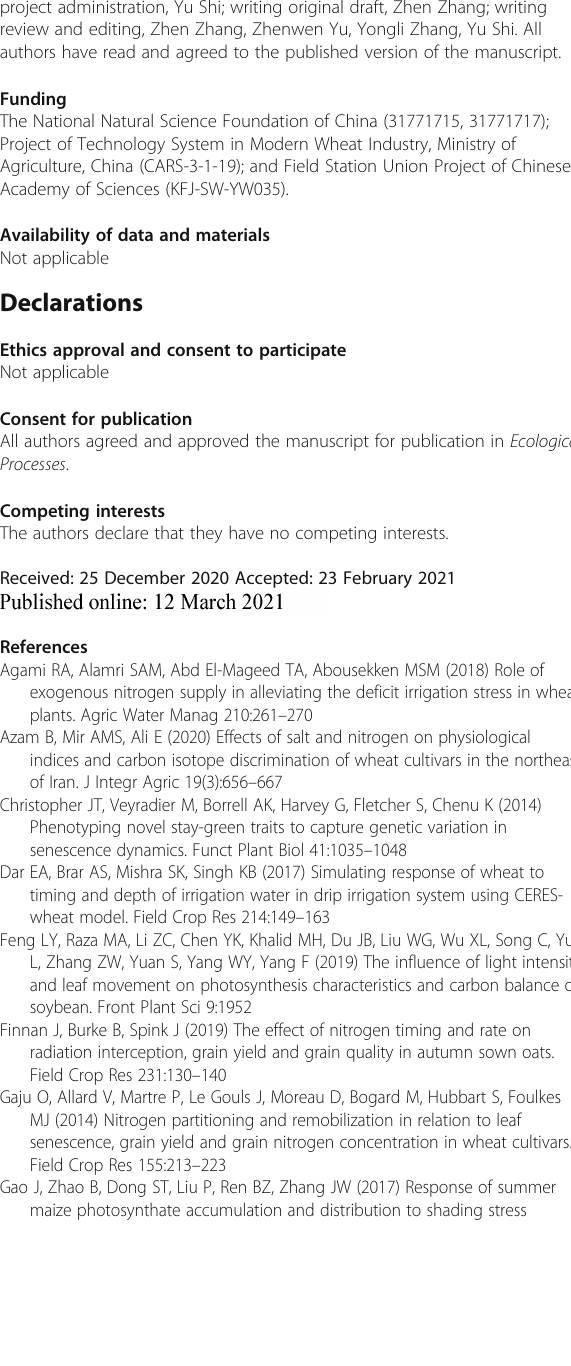
Additional file 1: Table 1 . Results of ANOVA about Fig. 1. Table 2 . Results of ANOVA about Fig. 2. Table 3 . Results of ANOVA about Fig.